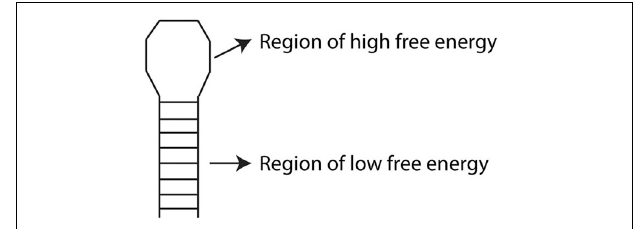
FIGURE 2 | Schematic overview of free energy ( (cid:2) G ) analysis of predicted RNA hybridization structure. A hairpin loop is shown with the loop corresponding to a region of high free energy (a positive (cid:2) G ) and the stem corresponding to a region of low free energy (a negative (cid:2) G ).